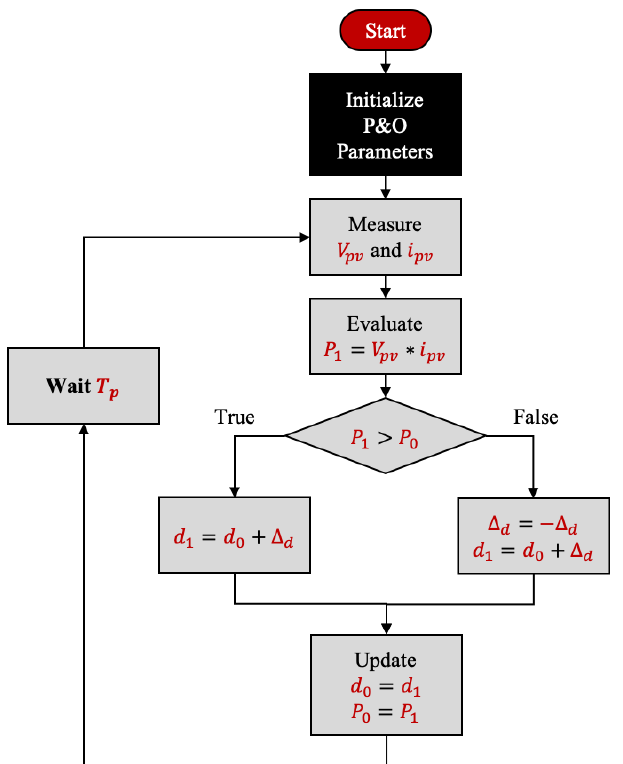
Figure 5. Flow chart of the Perturb and Observe (P&O) Maximum Power Point Tracking (MPPT)